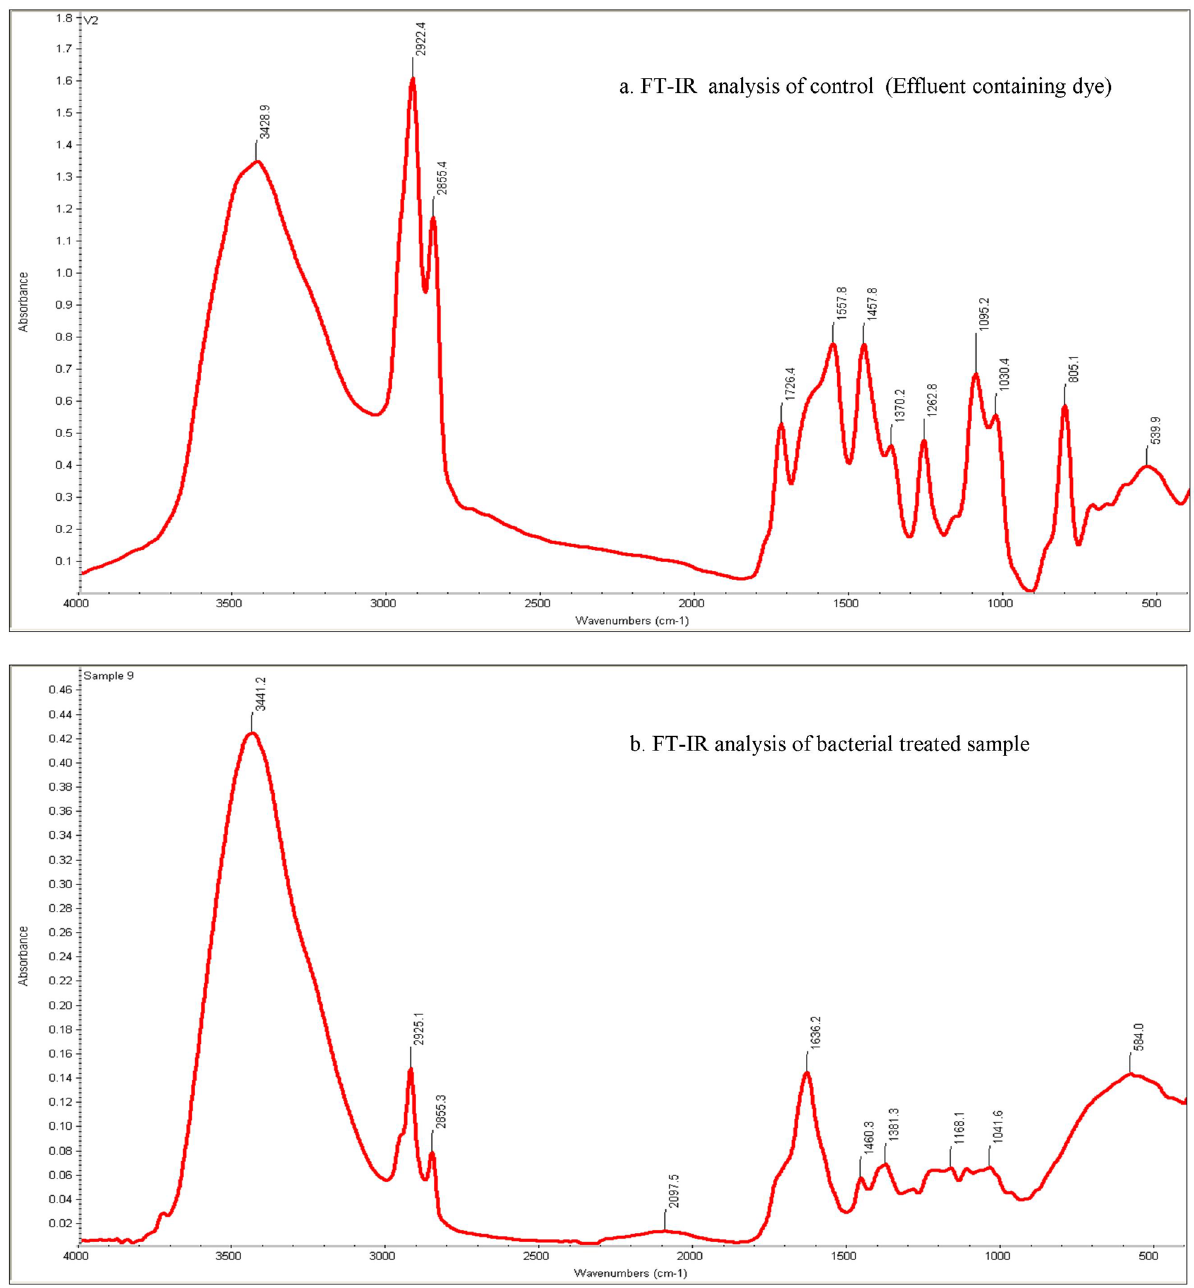
Figure 3. FTIR Analysis of ( a ) Control (Effluent containing the dye) and ( b ) Bacterial treated effluent (20 reducing equivalents than the azo dye. The isolated Pseudomonas strain when grown under aerobic condition showed minimal growth. Previous studies have reported that when oxygen concentration exceeds the air satura- tion level, reactive oxygen species (ROS), such as superoxide (O 2− ) and hydrogen peroxide (H 2 O 2 ), builds up as resultant by-product 15 . Inhibition by oxygen is because of restoration of the oxidized form of flavins. The oxygen toxicity effect thus affects the growth rate significantly.Few research studies correlated the level of colour removal with the dye class rather than with the molecular features 16 (Table 4). The enzymatic mechanism for degradation of azo compounds by bacterial cell is improved by the occurrence of electron-donating methyl and methoxy substituents and worsened by the presence of electron withdrawing chloro, fluoro, and nitro substituents 17 . The strain possessed azoreductase enzyme which is known to activate direct oxidation of azo dyes by highly reactive electrophilic diazonium salts. Azoreductases are flavin-containing group of enzymes that uses nicotinamide adenine dinucleotide or nicotinamide adenine dinucleotide phosphate as a reducing equivalent 18 . Previous genomic studies of the Pseudomonas spp. have highlighted the presence of genes responsible for the production of laccase and NADH-DCIP reductaseenzymes which equally contributes